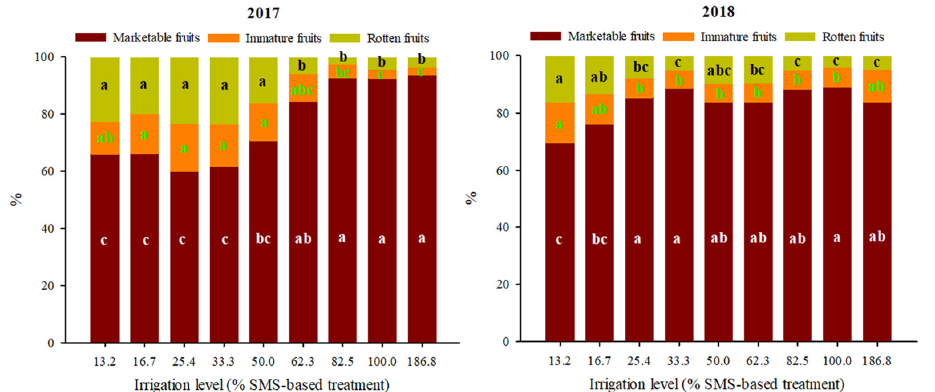
Figure 5. Effect of irrigation level on percentage by fresh weight of marketable, immature, and rotten fruits of processing tomato in 2017 and 2018. SMS = soil moisture sensor. Data are back transformed from arcsine transformation. In each year, different letters within each fruit group indicate significant differences according to Duncan’s multiple range test ( p = 0.05). Fruit fi rmness outcomes was higher in 2018 compared to 2017 (3.6 vs. 1.05 kgf) while an increase of irrigation level caused a linear decrease of fruit fi rmness only in 2018 (Figure 6).